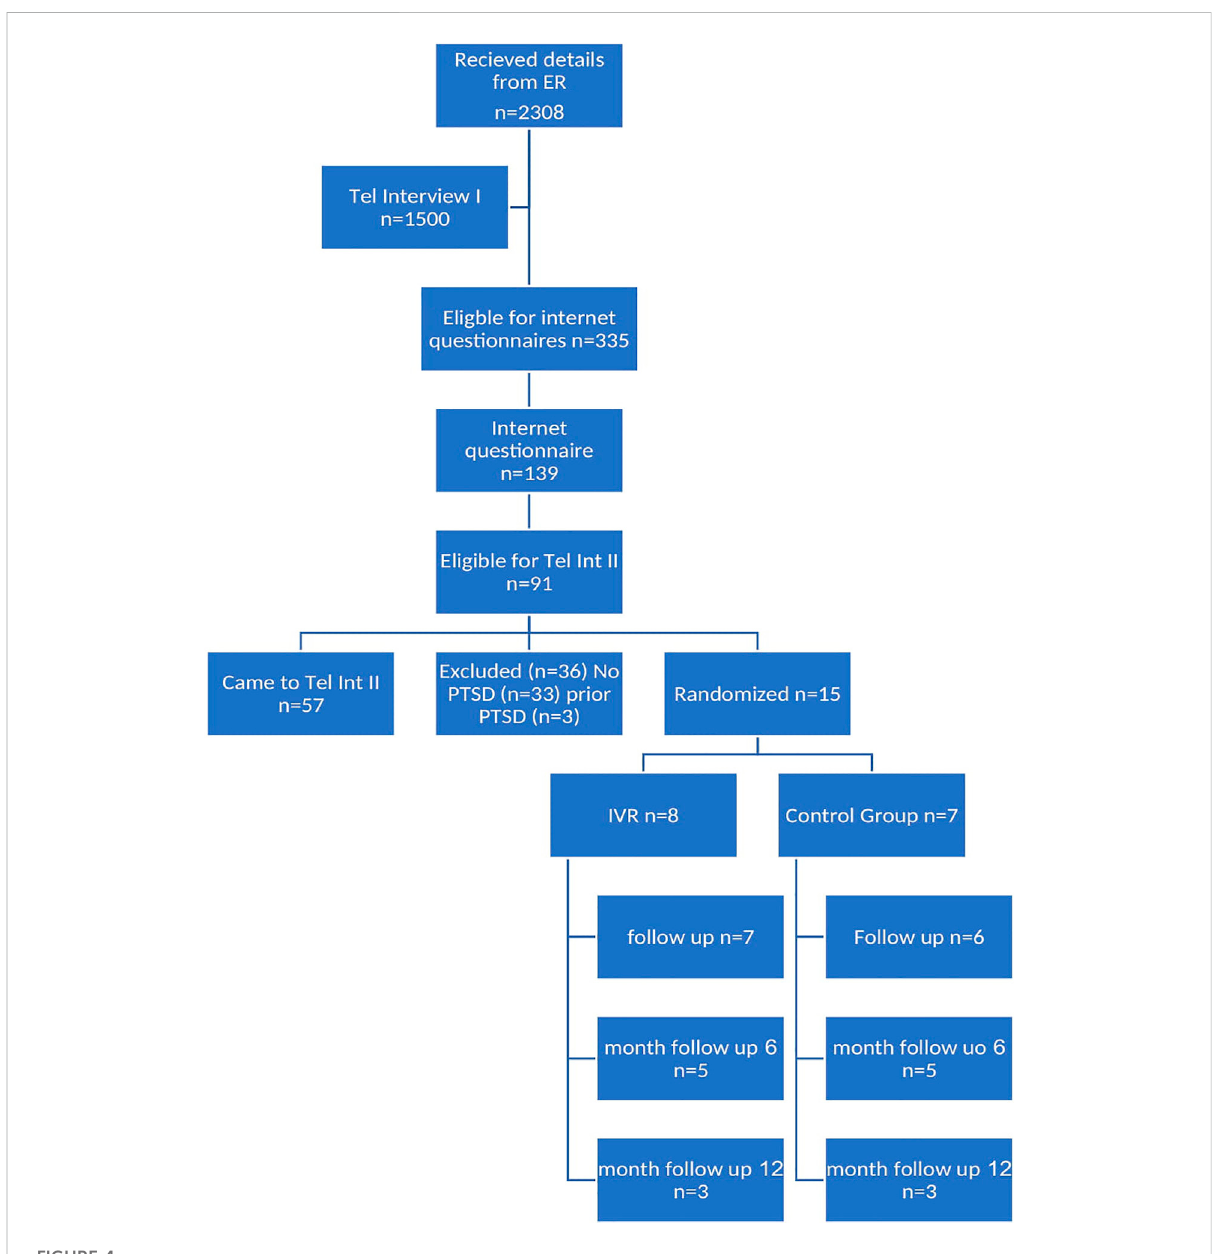
FIGURE 4 CONSORT